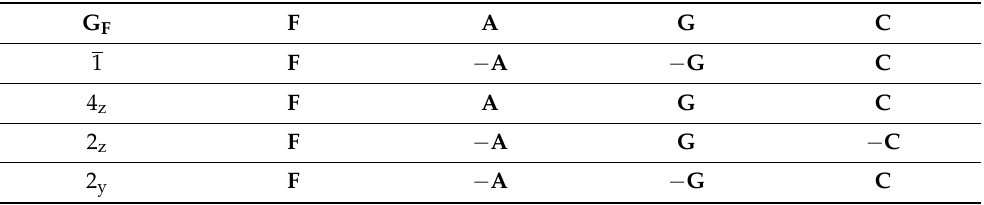
Table 4. Permutation transformations of basis vectors. G